Question: Provide a one-line summary of what is displayed.
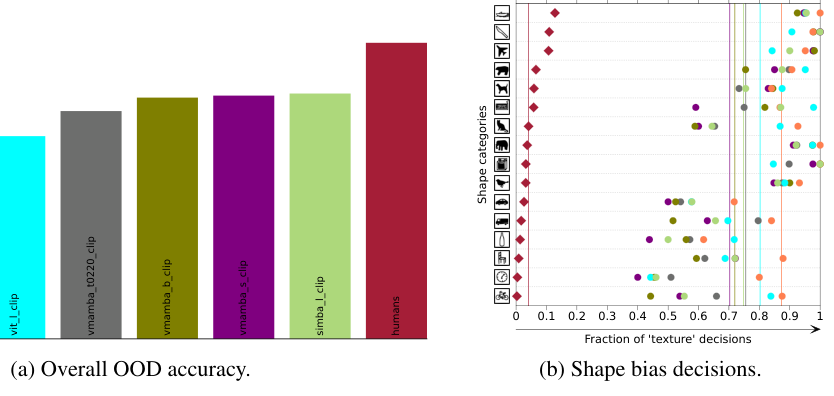
Answer: Overall performance and shape bias.